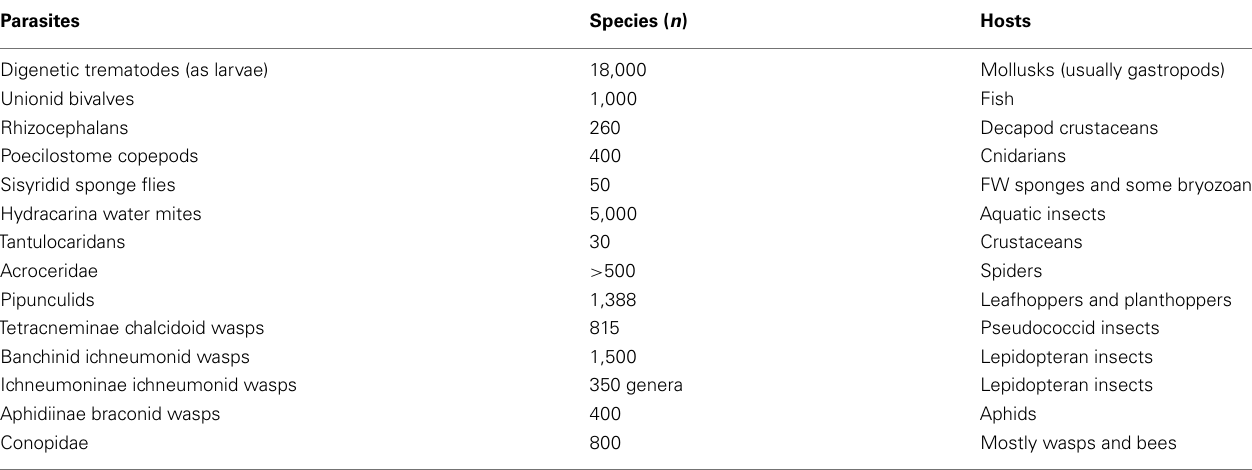
FIGURE 2 | One scenario for early in the divergence of animals is that different lineages (A–D) have fundamentally similar immune systems such that they all are colonized by the same parasites. In the case shown at the top, an immunological innovation occurred in lineage A, that allowed it to resist these parasites.This may have permitted a subsequent radiation in